Question: Summarize what this figure shows in one sentence.
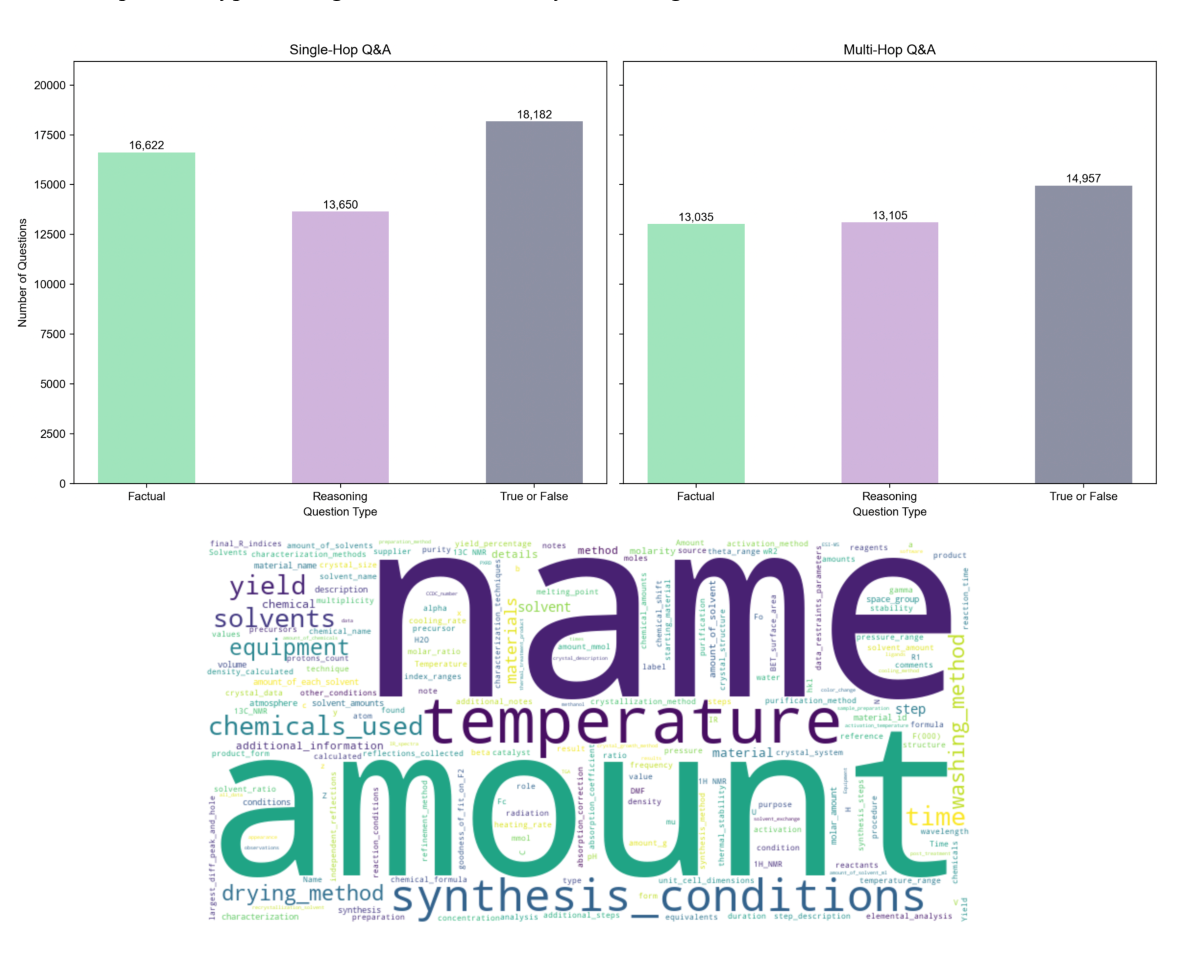
Answer: Results for the RetChemQA dataset. Total number of questions generated (and the type: Factual,  Reasoning, and True/False) in the single-hop and multi-hop datasets(top); and a word cloud showing the different  synthesis related keywords generated in the synthesis conditions dataset (bottom). The size of a word indicates its  frequency or importance in the text being analyzed, where larger words represent those that appear more frequently,  while smaller words represent those that appear less frequently.